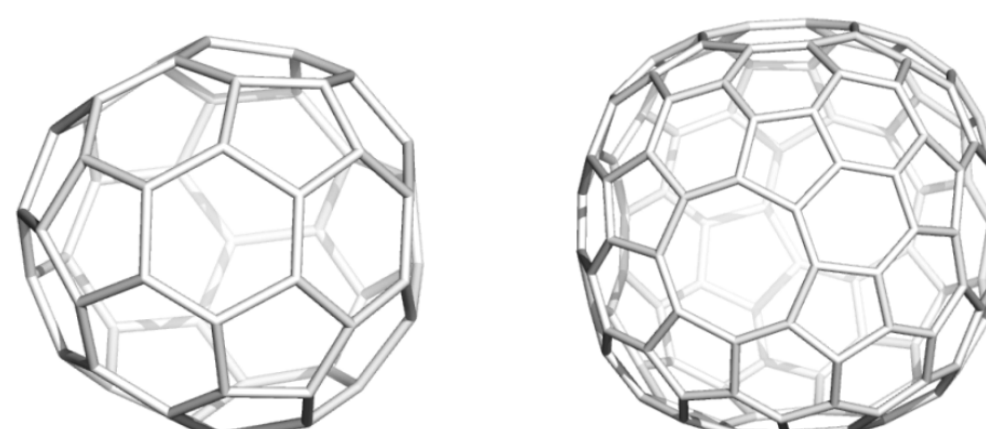
Figure 7. Fullerenes tessellated by 6-Sumanene: C